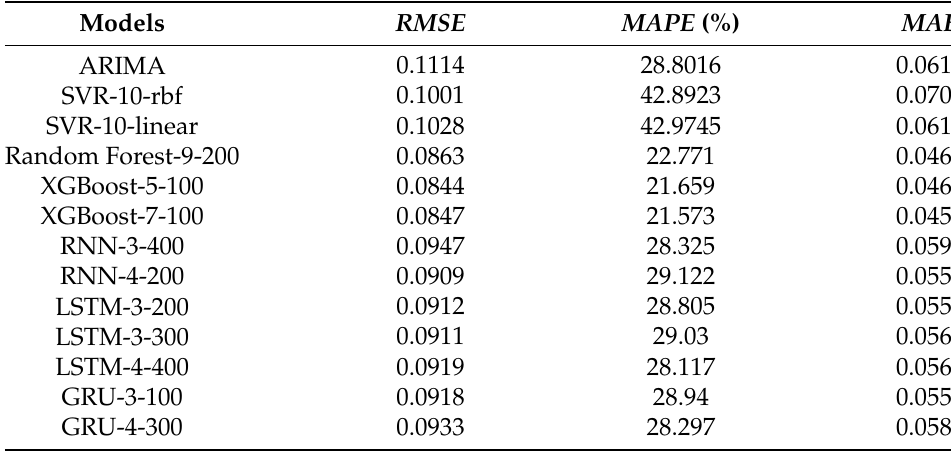
Table 5. RMSE , MAPE , and MAE results for the selected analysed